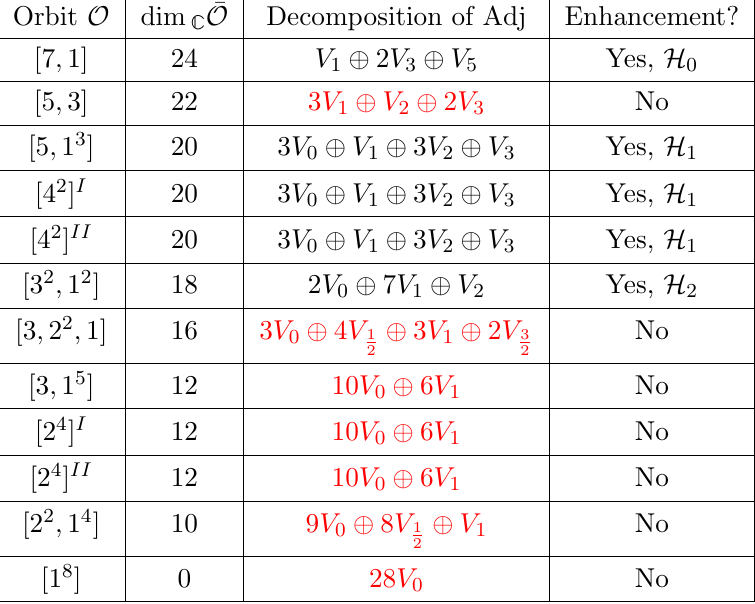
Table 2 . All nilpotent orbits of so (8) and their adjoint decomposition. By V j we indicate the representation of spin j under the embedded